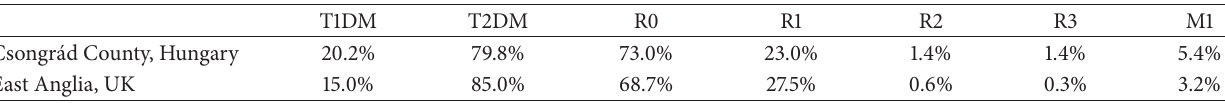
Table 2: Distribution of the DM types and DR grade in the studied population in relation to the UK-based grading system implemented by the Spectra (cid:2) analysis.